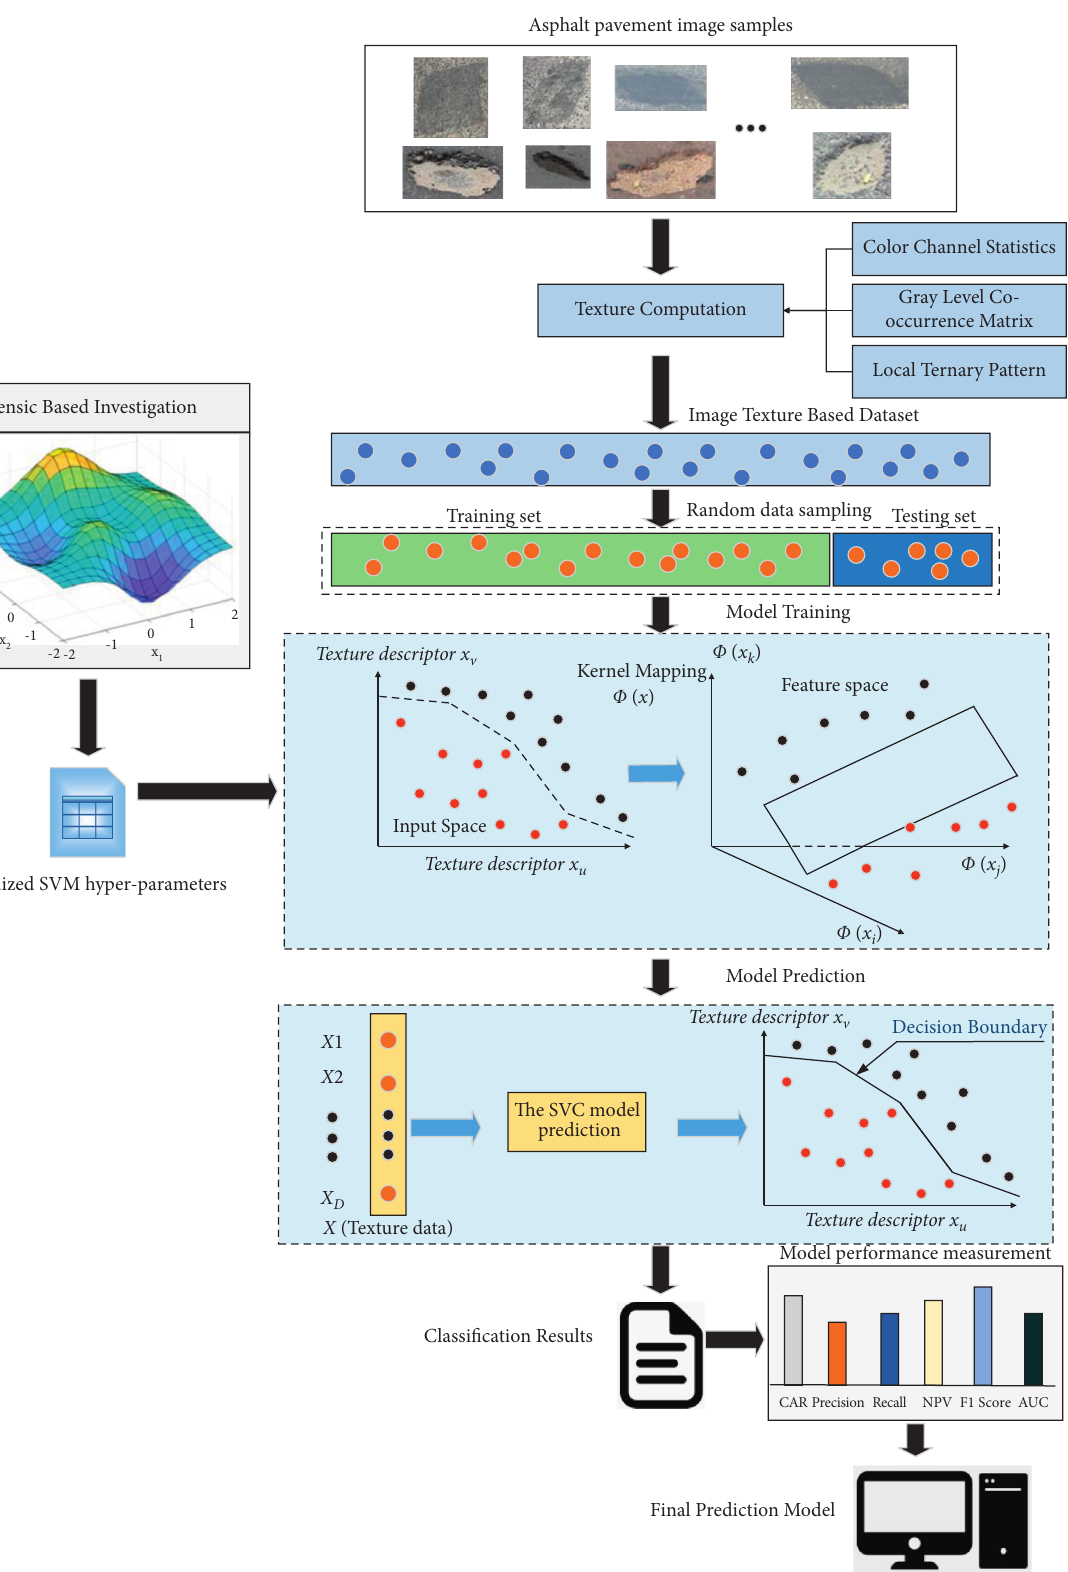
Figure 6: The proposed image processing-based Forensic-Based Investigation optimized machine learning for patched and unpatched pothole